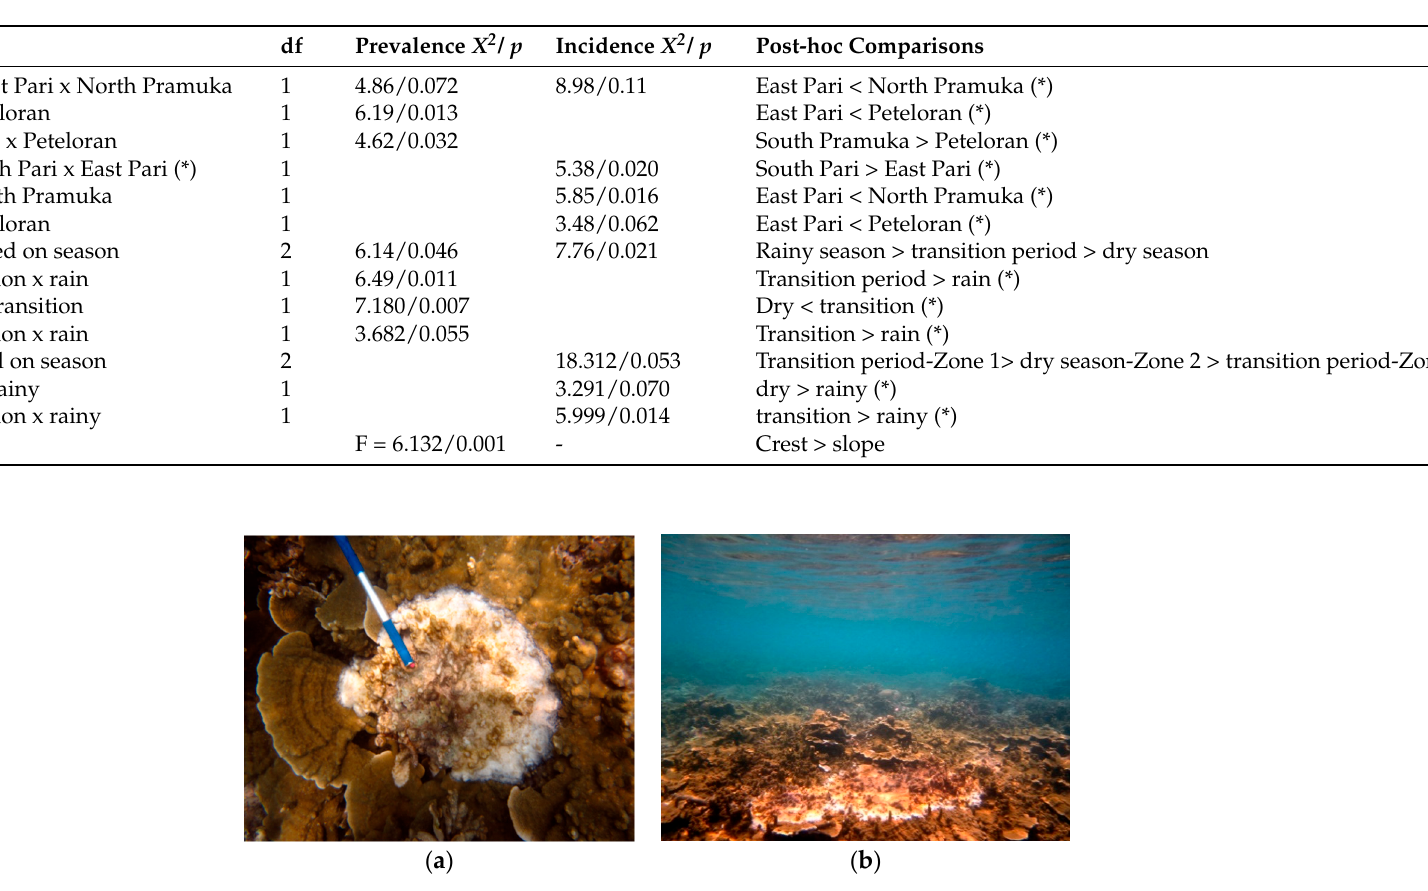
Table 1. A Kruskal-Wallis test to determine the effects of site and season on black band disease (BBD) prevalence and incidence. The effect indicate less than (<), higher than (>) and difference between location and season based on 95% statistic level (*).